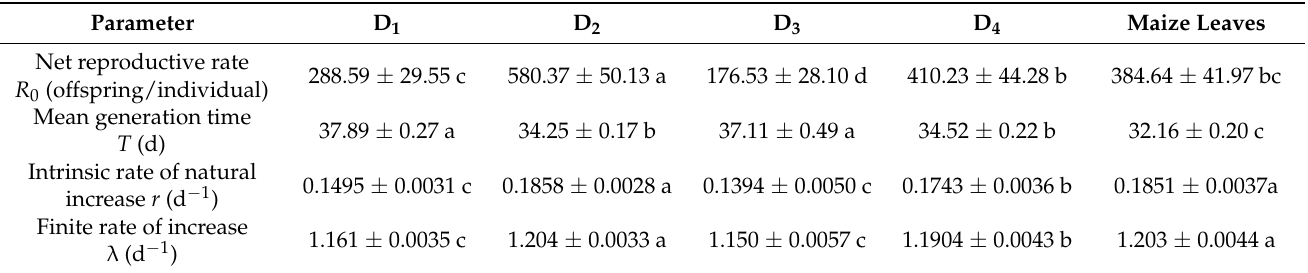
Table 4. Life table parameters (mean ± SE) of Spodoptera frugiperda individuals fed different diets.